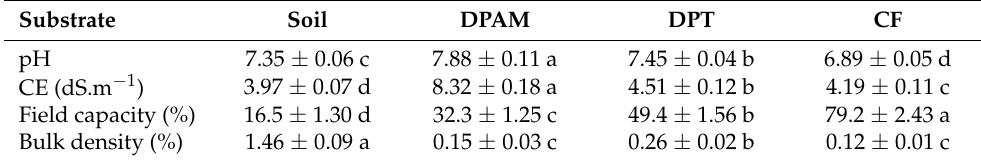
Table 1. Physico-chemical properties of the studied substrates. DPAM: compost of date palm residues and animal manure; DPT: compost of date palm trunk; CF: coconut fiber, compared with soil substrate.